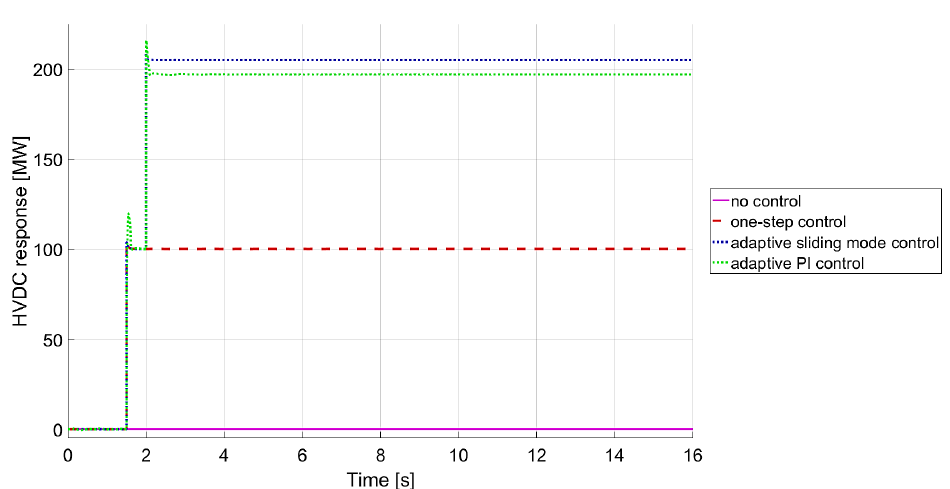
Figure 8. HVDC active power in Configuration I in case of big disturbance.